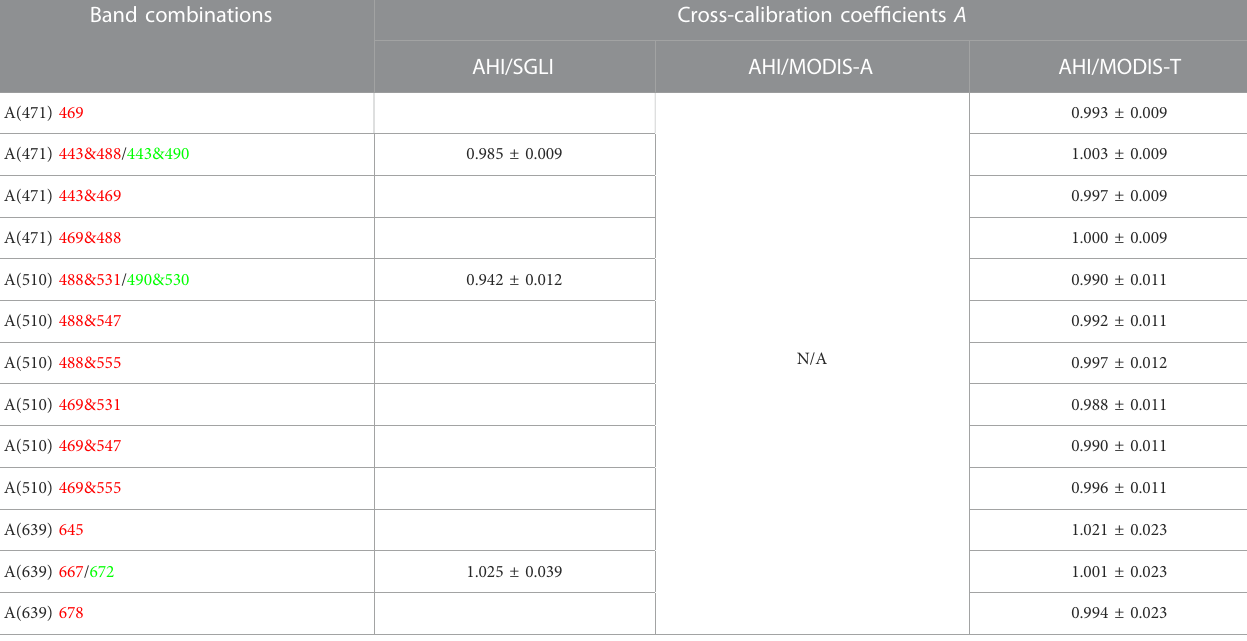
TABLE 6 Same as Table 5, but for coincidences obtained on 22 January